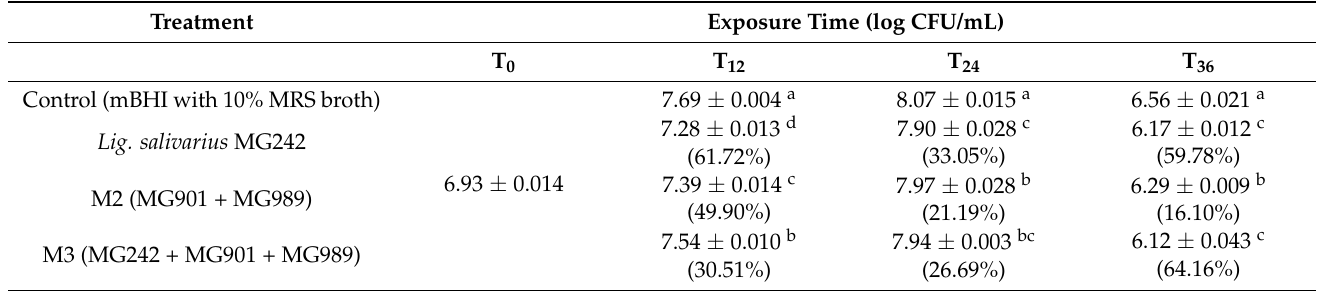
Table 1. Characterization of the antimicrobial properties of the LAB strains.